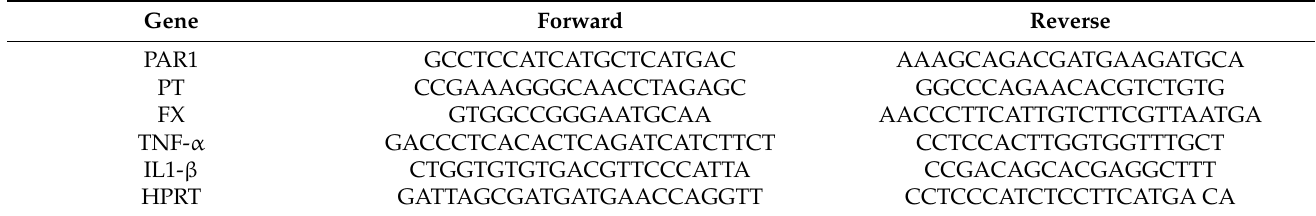
Table 1. List of primers used to assess coagulation and inflammation mRNA